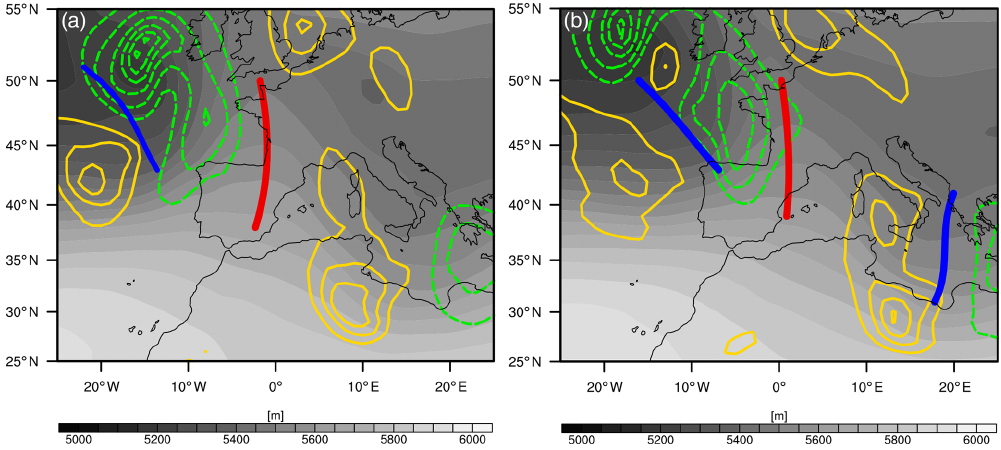
Figure 3. The 500hPa trough (blue) and ridge (red) axes at (a) 06:00UTC and (b) 12:00UTC on 12 January 2010: quasi-geostrophic omega (from 0.1 to 1 in steps of 0.1ms − 1 ; positive values in yellow indicate descent, and negative values in green indicate ascent) and geopotential height (m; gray